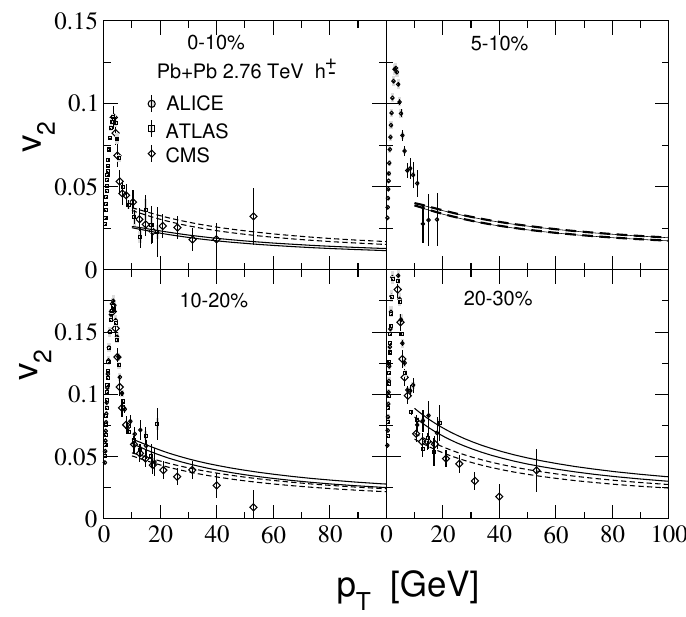
Figure 8 . v 2 of charged hadrons in 2 . 76 TeV Pb+Pb collisions for the initial fireball eccentricity (cid:15) 2 calculated in the optical (solid) and Monte-Carlo (dashed) Glauber model for scenarios without and with (bottom to top) mQGP formation in pp collisions. The parameters are the same as for figure 4. Data points are from ALICE [85], ATLAS [86], and CMS [87].